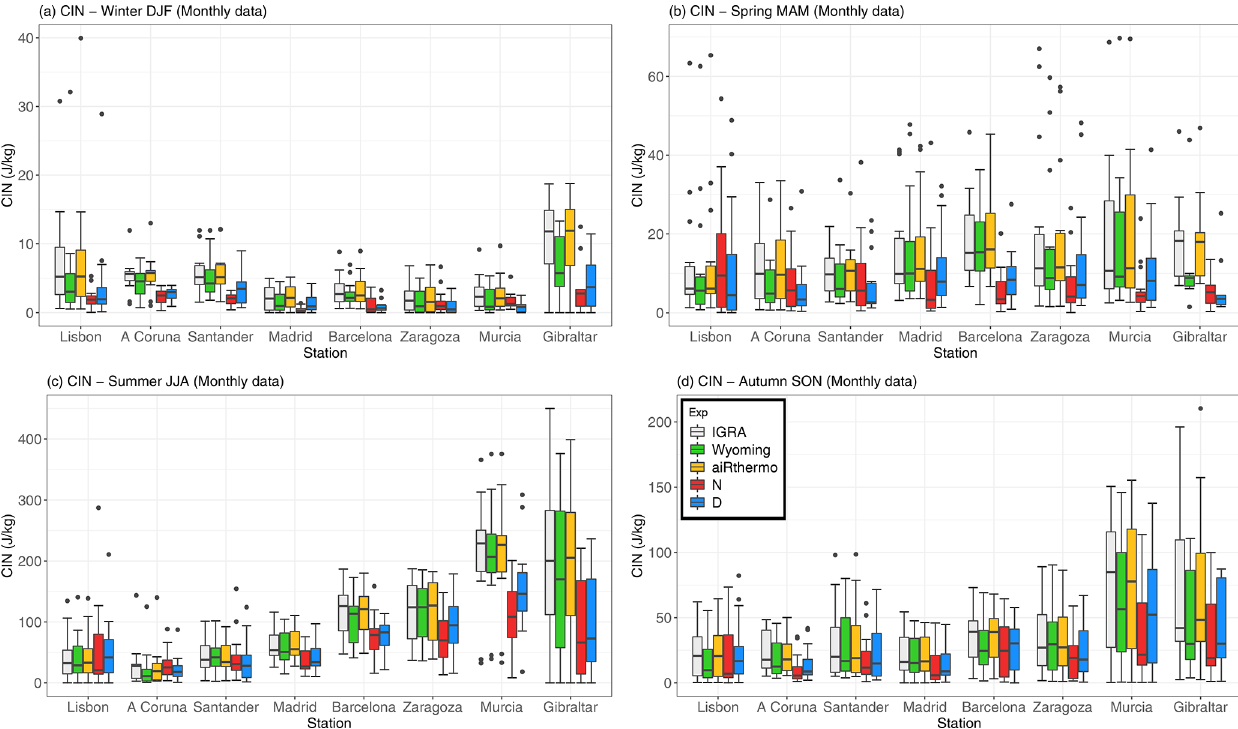
Figure 7. Same as Figs. 5 and 6 but for CIN.